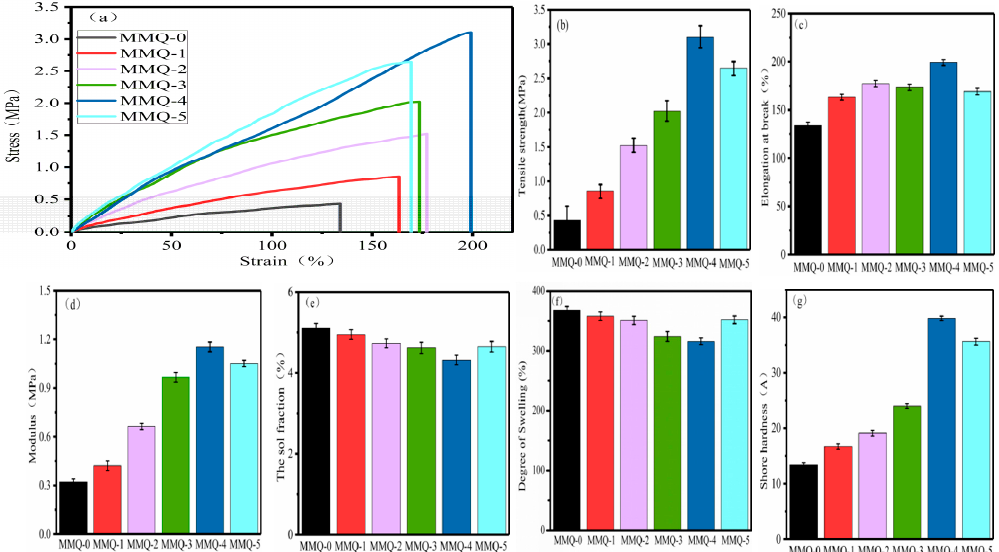
Figure 6. The mechanical properties of RTV silicone rubbers: ( a ) stress–strain curves; ( b ) tensile strengths; ( c ) elongation at break; ( d ) Young ′ s Modulus; ( e ) sol fraction; ( f ) degree of swelling; and ( g ) shore hardnesses of RTV silicone rubber.